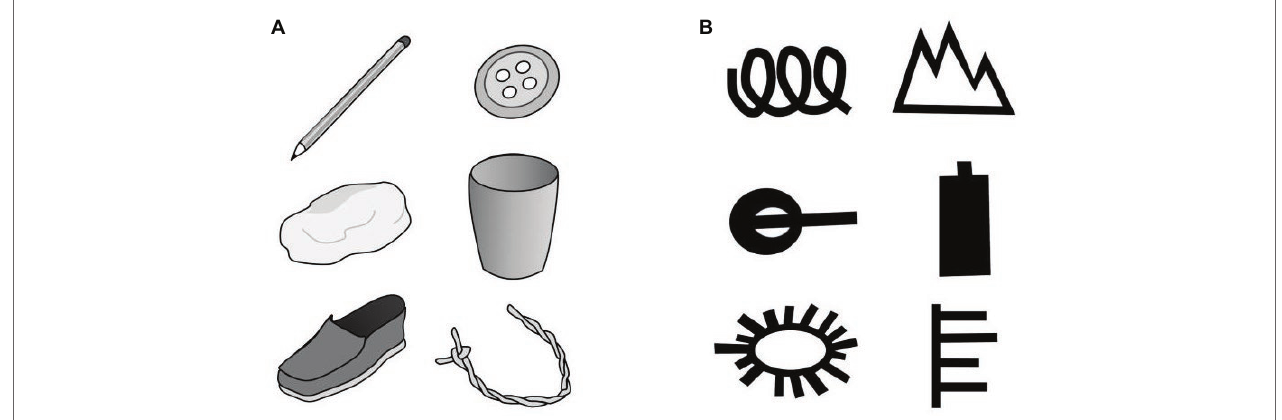
FIGURE 1 | The objects and pattern used in the creativity tasks. (A) Schematic drawings of the objects of the alternative uses task. The objects given to the children were real objects. (B) The pattern presented to the children in the pattern association ask. Children were presented the pattern printed on a card, one after another. Note that the item on the upper left corresponds to example item, used for the instruction and training of each